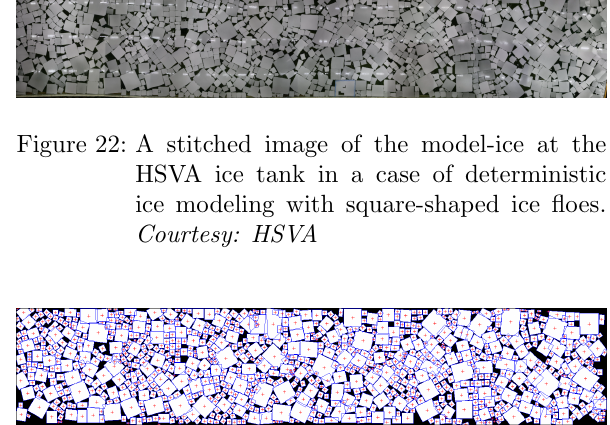
Figure 23: Identified ice floes from the GVF snake algo- rithm, and further rectangularized to iden- tify overlapping parts between the